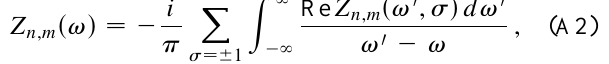
Fig. 1. Since Re (cid:90) (cid:110) (cid:44) (cid:109) is zero below the cutoff frequency,